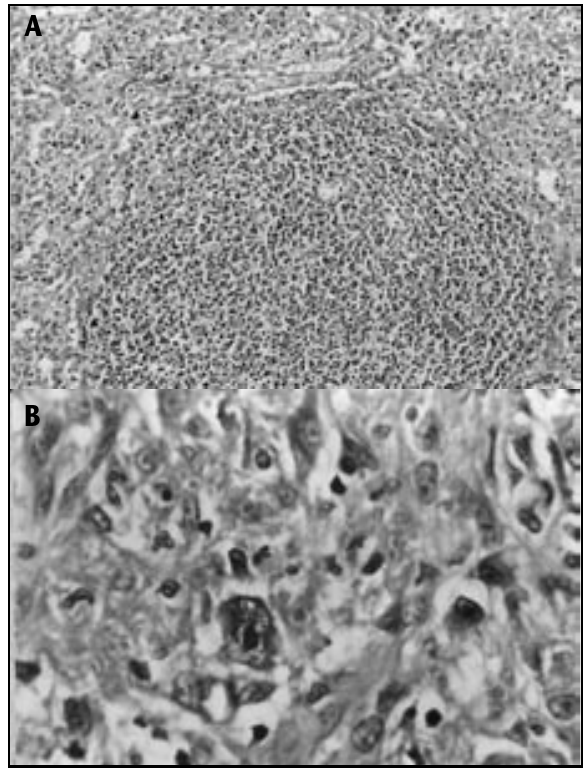
Figure 3 – A: Microscopic section of liver showing infiltration of portal space by small cell lymphoma, similar to that seen in the white pulp of the spleen